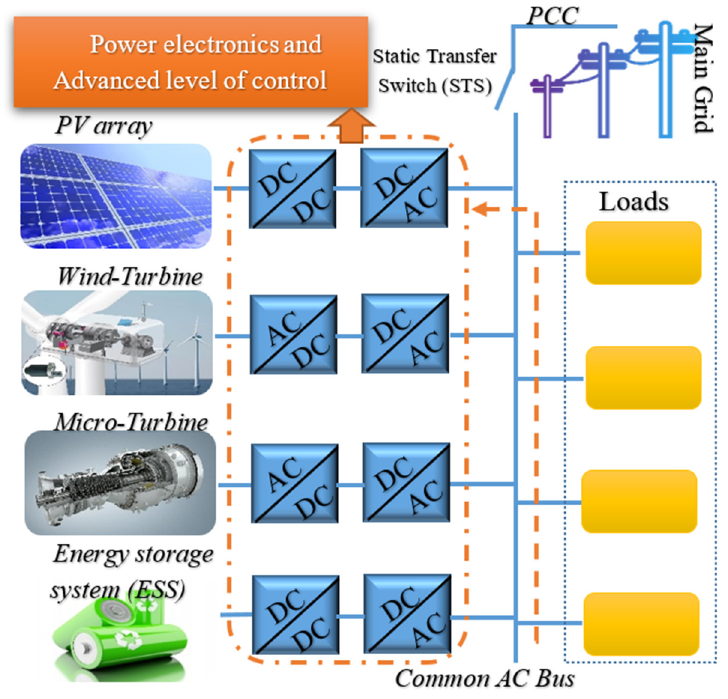
Figure 1. Structure of the microgrid.